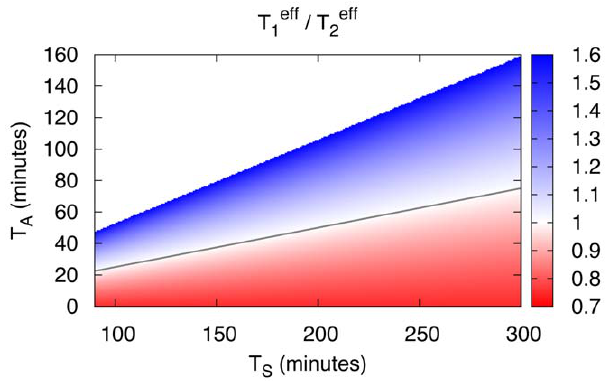
Figure 3. Optimal growth strategy for homogeneous popula- = T eff of doubling times of homogeneous tions. The ratio T eff 1 2 populations growing with either strategy 1 or strategy 2 is shown for varying adaptation times T A and switching times T S . The effective of the population growing with strategy 1 is given doubling time T eff 1 of the population growing by Eq. (8), the effective doubling time T eff 2 with strategy 2 is given by Eq. (9). In the parameter range where T eff = T eff is larger than 1 (region shown in blue) a strategy 2 population 1 2 is advantageous (i.e. the population with strategy 2 grows faster). In the = T eff is smaller then 1 (shown in red), strategy 1 is region where T eff 1 2 advantageous. The grey line represents the phase boundary parame- terized by Eq. (10). Data shown are for T 1 ~ 60min and T 2 ~ 80min . Here, and in the following Figs. only the range T A v T S = 2 , is shown. For higher values of T A , strategy 2 is trivially advantageous since strategy 1 cells stop growing as T A approaches T S .